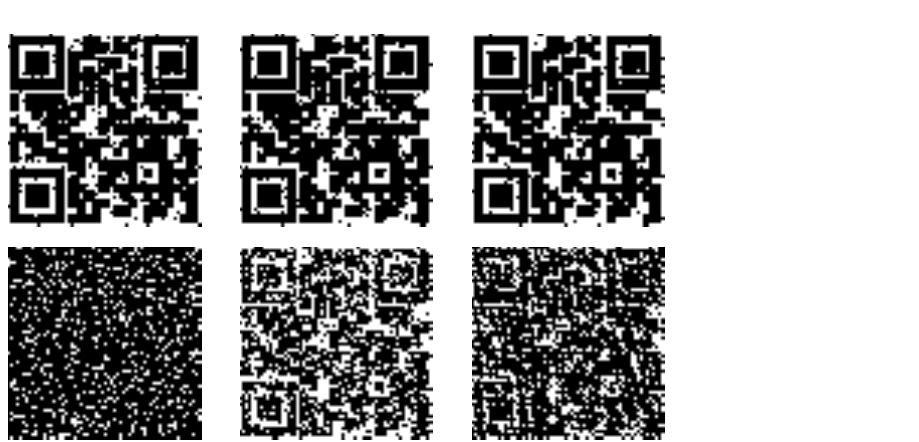
Figure 8. Median filter noise.